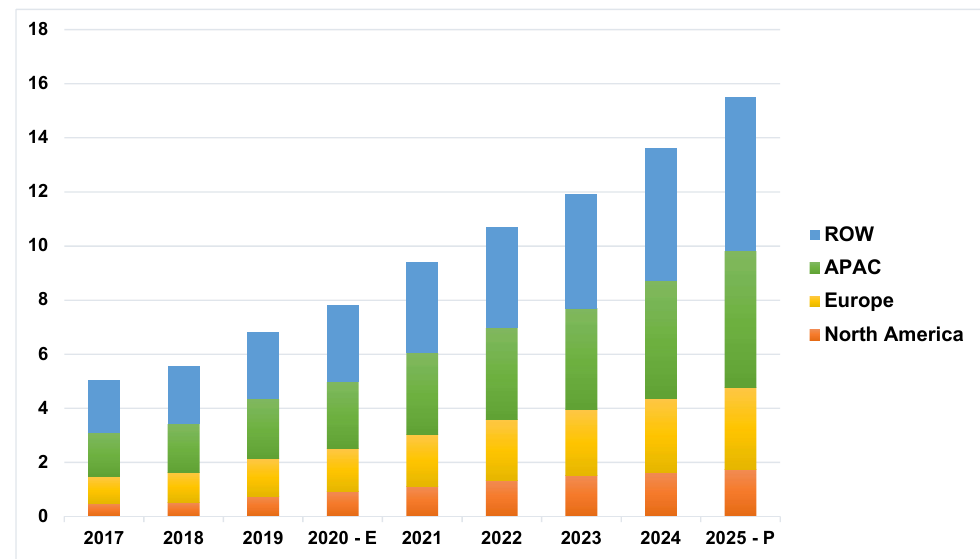
Figure 1. Worldwide I-IoT adaptation rate